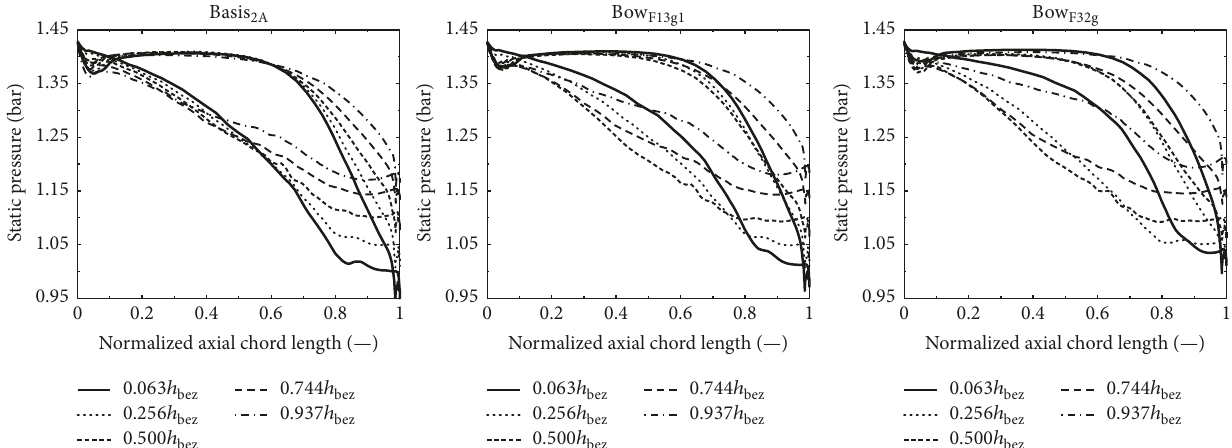
Figure 9: Pressure distributions over the blade profile of the stator at the 0.063 (thick line) 0.256, 0.5, 0.744, and 0.937 normalized blade